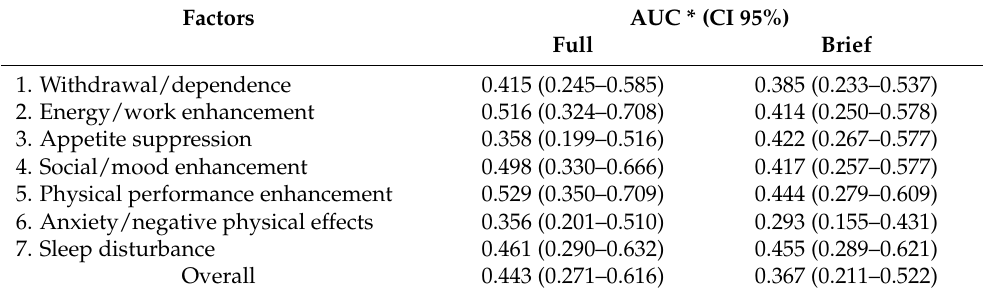
Table 4. Area under the ROC curve (AUC) of CaffEQ-BR full and brief versions for ADORA2A genotypes.